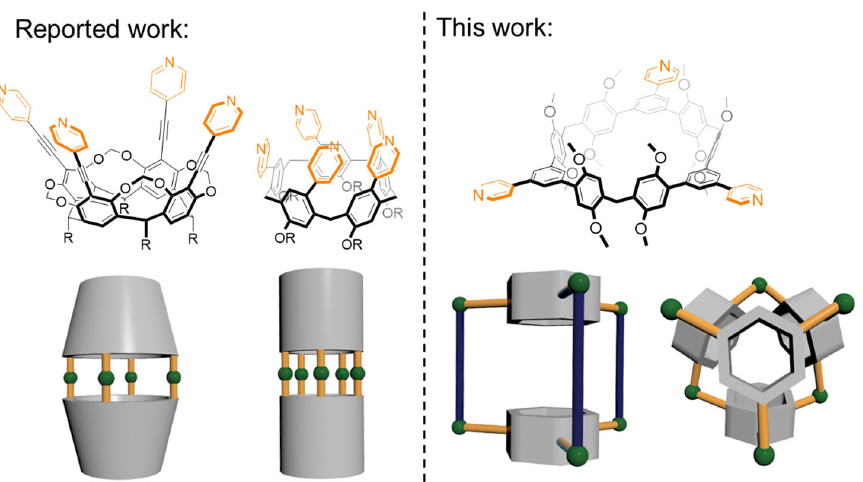
Figure 1. Schematic illustration of macrocyclic ligands with portal coordination sites (reported work) and equatorial coordination sites (this work) for the construction of coordination ‐ driven self ‐ assembly metallacages.